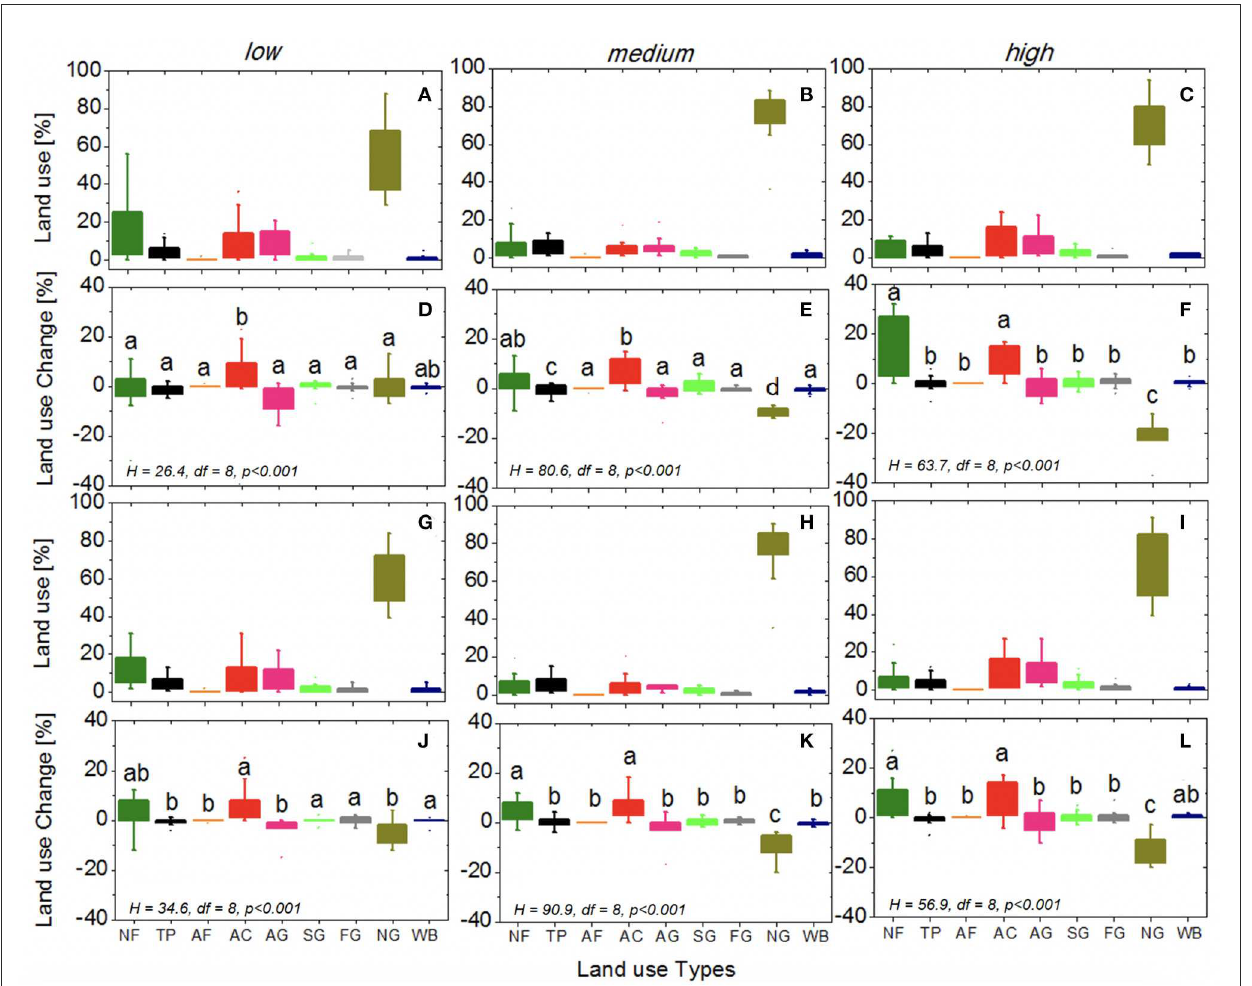
FIGURE5 Land use (%) of total surface in 2000 calculated for the polygon where the monitoring site was inserted (A–F) and 5km radius (G–L) around the 44 monitoring sites in rural Uruguay (see Figure 3A). The main land-use types are natural (mostly gallery) forests (NF, dark green), timber plantations (TP, black), agroforestry ( Citrus and Vitis cultures, AF, orange), agriculture (AC, red); artificial pastures (AG, pink), “improved pastures”: improved by sowing legumes (SG, light green) and by fertilization (FG, gray); natural grasslands (“Campo natural”, NG, olive), water bodies and others (WB, blue). Sites are categorized in sites of low ( N = 13), medium ( N = 18) and high ( N = 13) land-use change. Land use changes to silvi- and agriculture occurs mainly at the expenses of natural grasslands. The different letters above the boxplot show significant differences between land-use types. The H, df and p values are